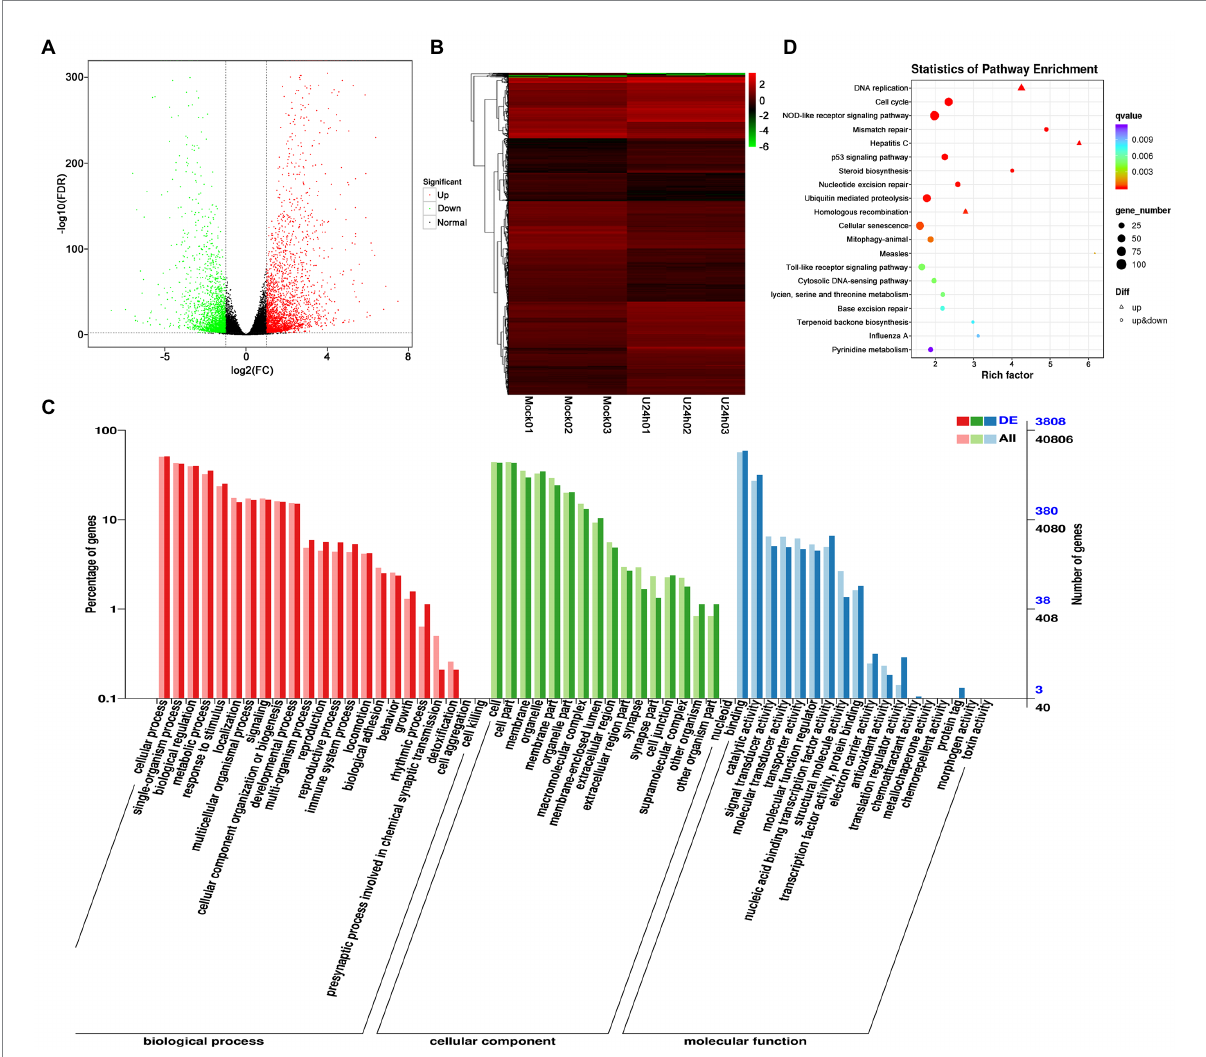
FIGURE 3 Comparison and enrichment analysis of DEGs in the Mock versus U-IHNV infection groups. (A) Volcano plot of DEGs. (B) Hierarchical clustering analysis of DEGs. (C) GO enrichment of DEGs. (D) KEGG enrichment analysis of